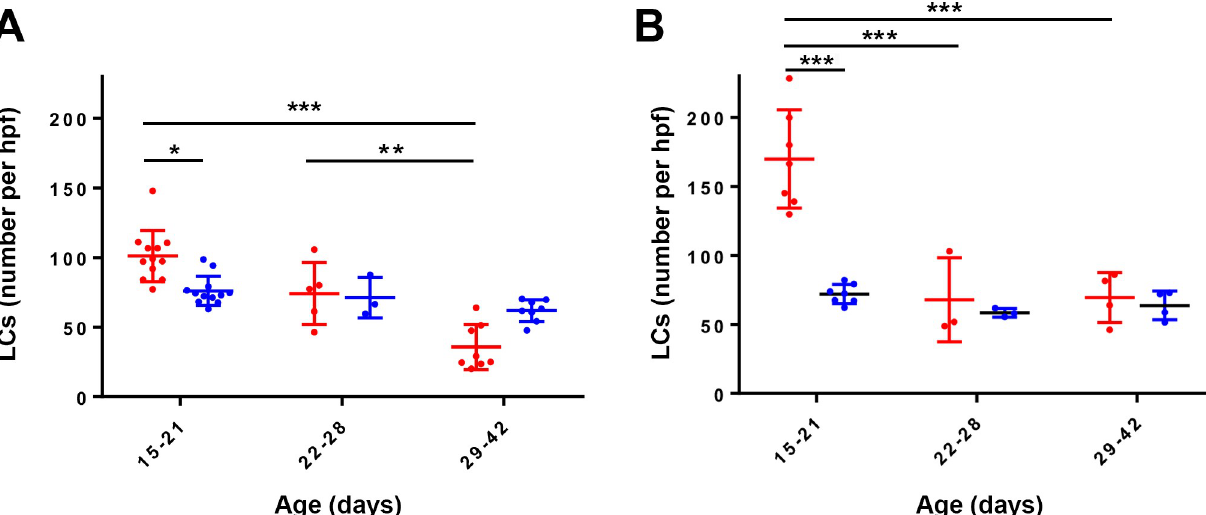
Fig 7. Quantitation of epidermal Langerhans cells in genetically modified mice. A. Epidermal Langerhans cells in Braf CA and Braf CA Tg(CD207-cre) mice. Epidermal sheets were prepared from Braf CA (blue dots) and Braf CA Tg(CD207-cre) (red dots) mice of the indicated ages and stained with fluorescence-conjugated antibodies against I-A/I-E. LCs were counted as described in Materials and Methods. Mean is plotted as the horizontal bar for each group and error bars indicate standard deviation. All comparisons were determined using a mixed model with a random effect that included mutational status, age, and an interaction term to analyze repeated measures over time. A Tukey-Kramer adjustment for p-values was then used to test the difference between mutational status and time. � , p = 0.0309; �� , p = 0.0062; ��� , p < 0.001. B. Epidermal Langerhans cells in Braf CA Pten loxP/loxP and Braf CA Pten loxP/loxP Tg(CD207-cre) mice. Epidermal sheets were prepared from Braf CA Pten loxP/loxP (blue dots) and Braf CA Pten loxP/loxP Tg(CD207-cre) (red dots) mice of the indicated ages and stained with fluorescence-conjugated antibodies against I-A/I-E. LCs were counted as described in Materials and Methods. Comparisons were made using a model similar to that described in A . ��� , p < 0.001.